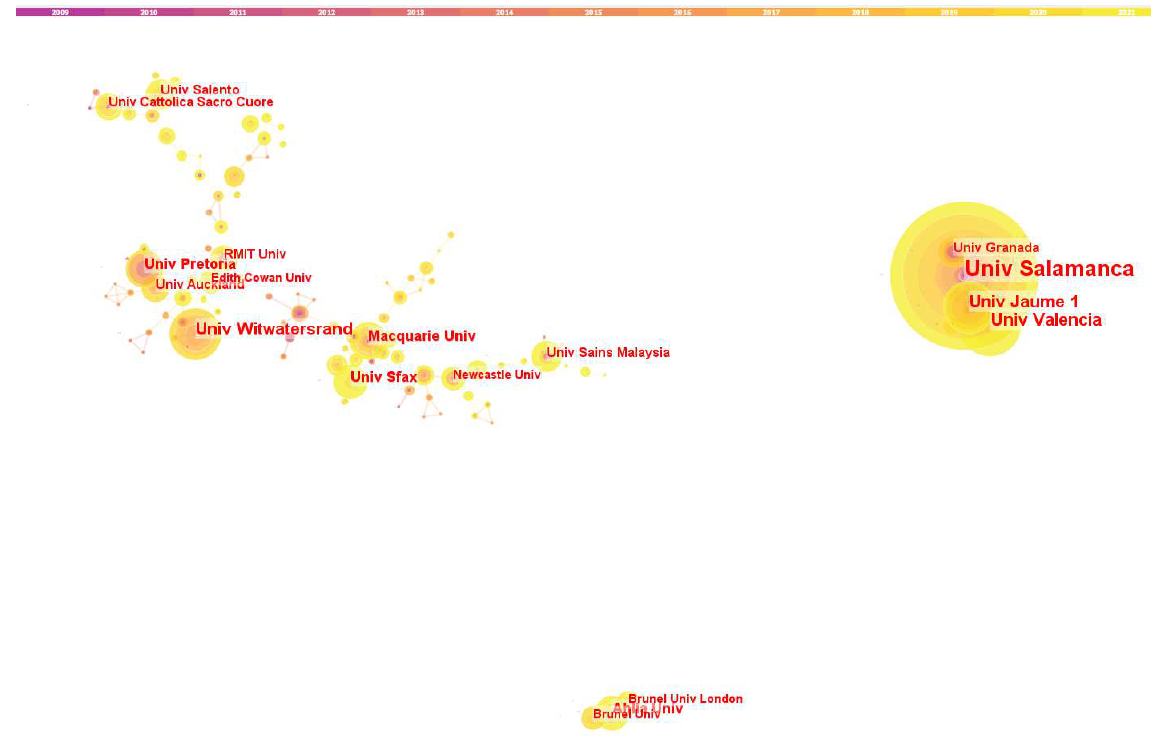
Figure 5. Map of articles published by